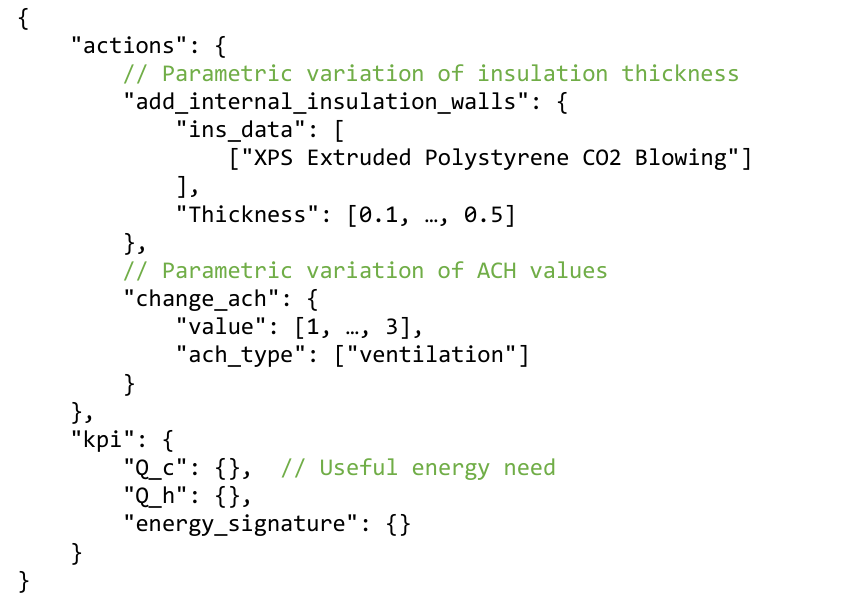
Algorithm 1. Example of an input *.json file to feed PREDYCE.